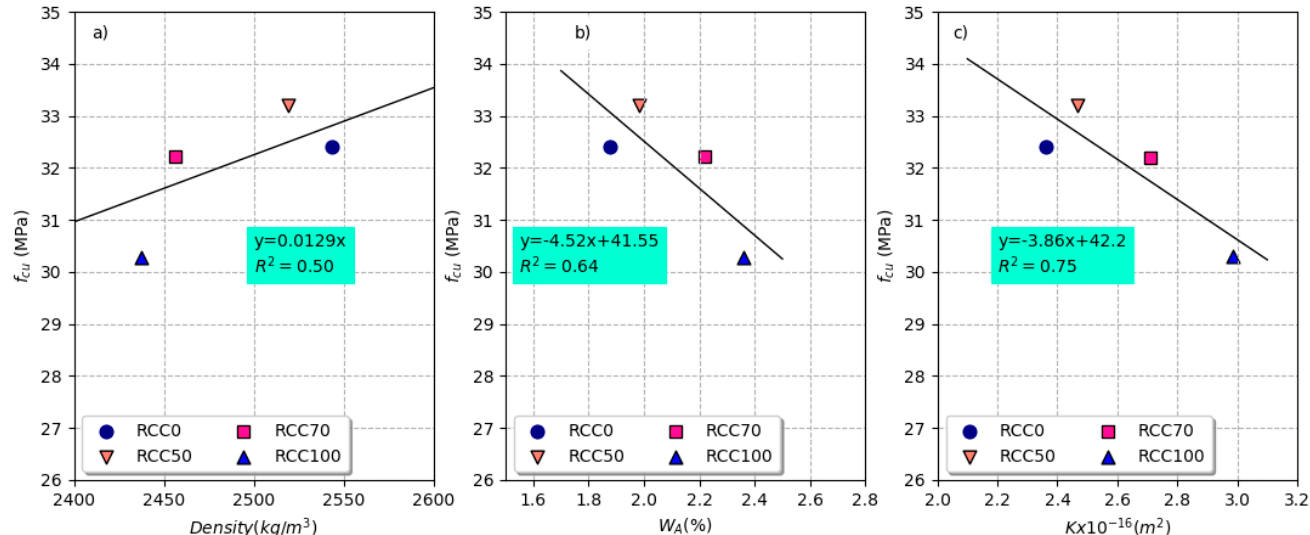
Figure 5. The compressive strength versus ( a ) the density, ( b ) water absorption, and ( c )